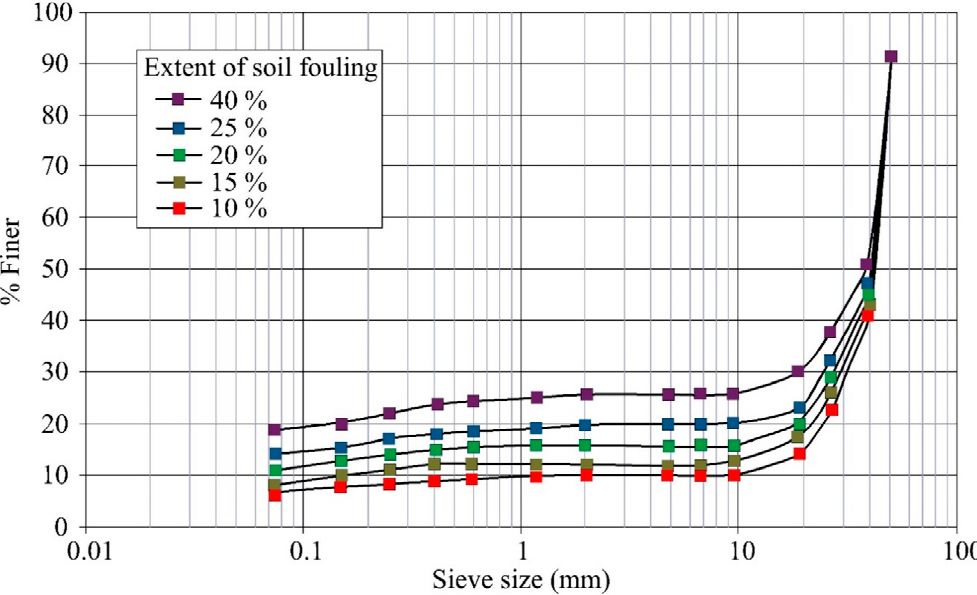
Figure 7. Ballast particle size gradation results with varied levels of clay fouling [31].